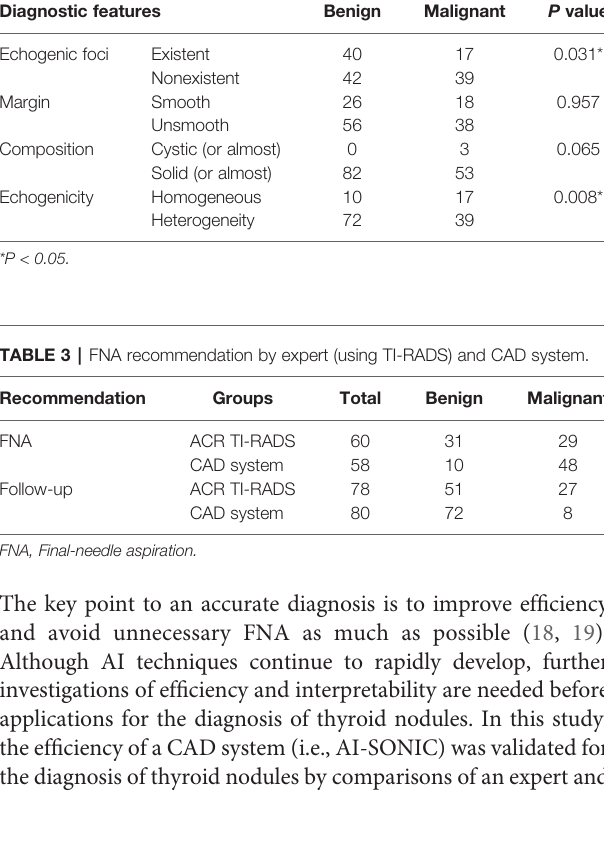
TABLE 2 | Correlation among diagnostic features detected by CAD and pathology result. Diagnostic features